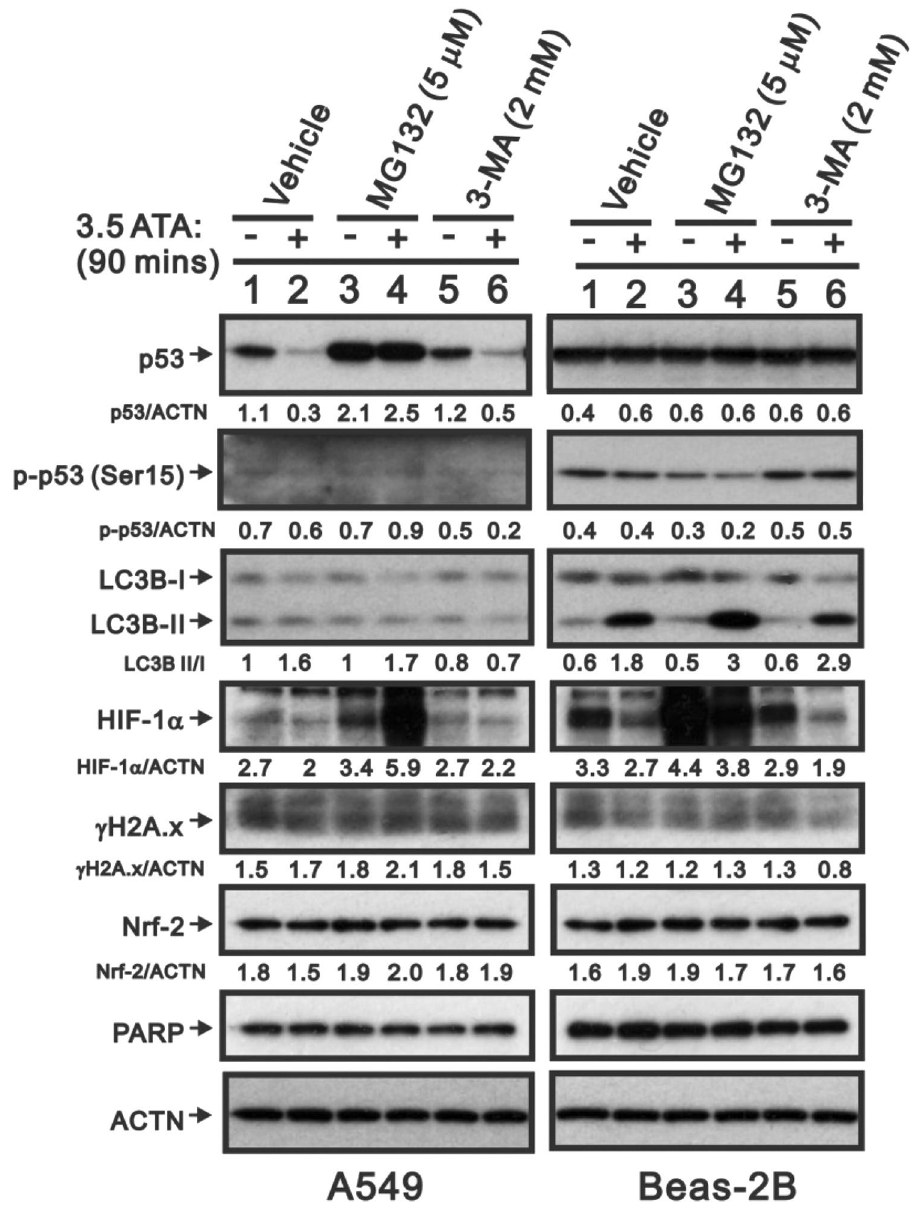
Figure 7. The reduced p53 protein level by HBOT was modulated through a ubiquitin-dependent proteasome degradation in A549 cells. The HBOT A549 and Beas-2 cell were treated with 3.5 ATA for 90 min in the presence of 5 mM MG132 (a proteasome degradation inhibitor) or 2 mM 3-MA(an autophagy inhibitor) for 4 h. These cell lysates were subject to the Western analysis for antibodies against p53, LC3B, HIF-1α, γH2A.x, Nrf2, PARP, and control protein ACTN. The results are representative of two independent experiments. Quantitative analysis of the western blot was listed under each